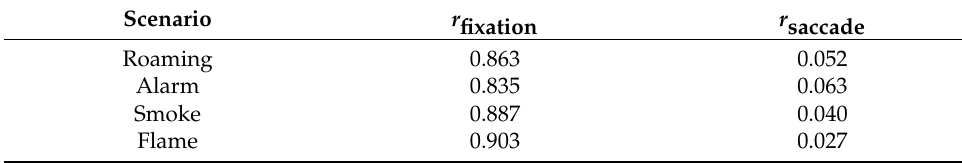
Table 9. Mean values of r fixation and r saccade.